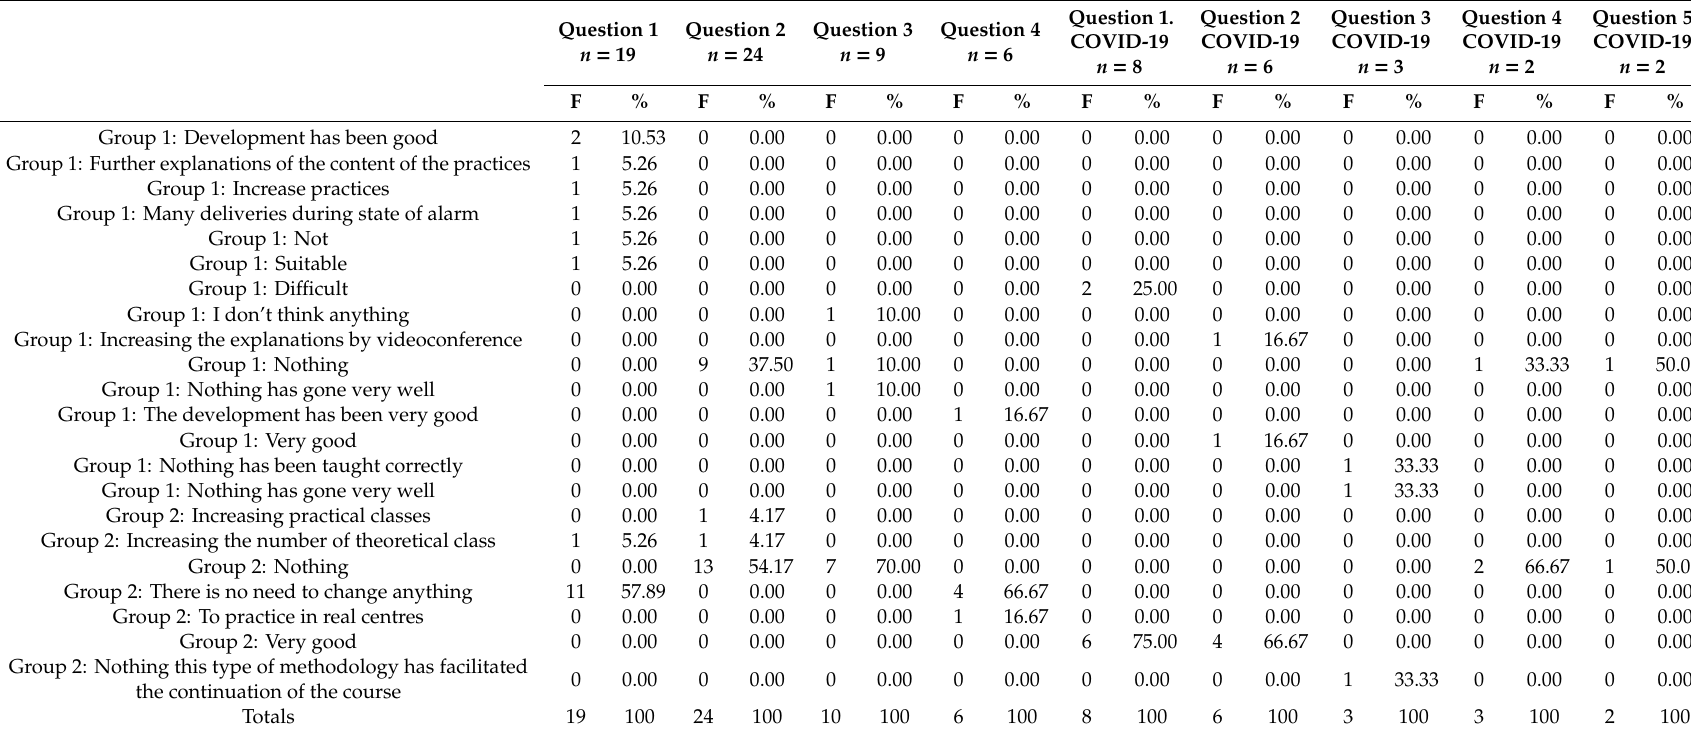
Table A4. Categorization of the answers to the open questions of the scale. Analysis of percentages and frequencies found with ATLAS.ti v.